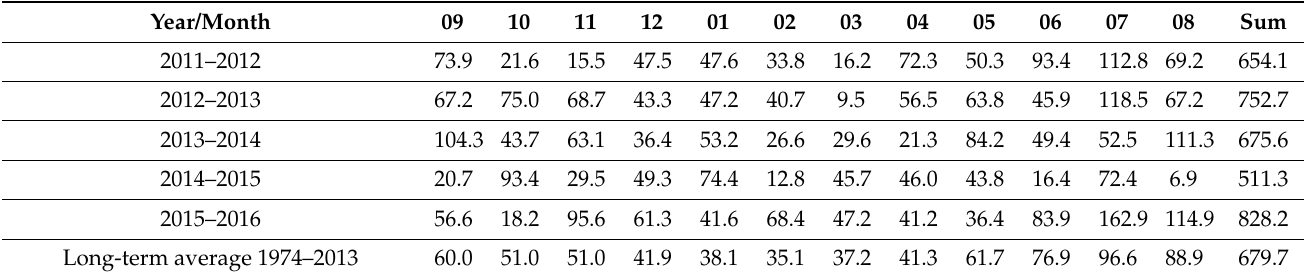
SAT = sum of active temperatures ( ≥ 10 ◦ C). Table 4. Precipitation (mm) during the winter rye growing season (September–August) in 2011–2016, Kaunas Meteorological